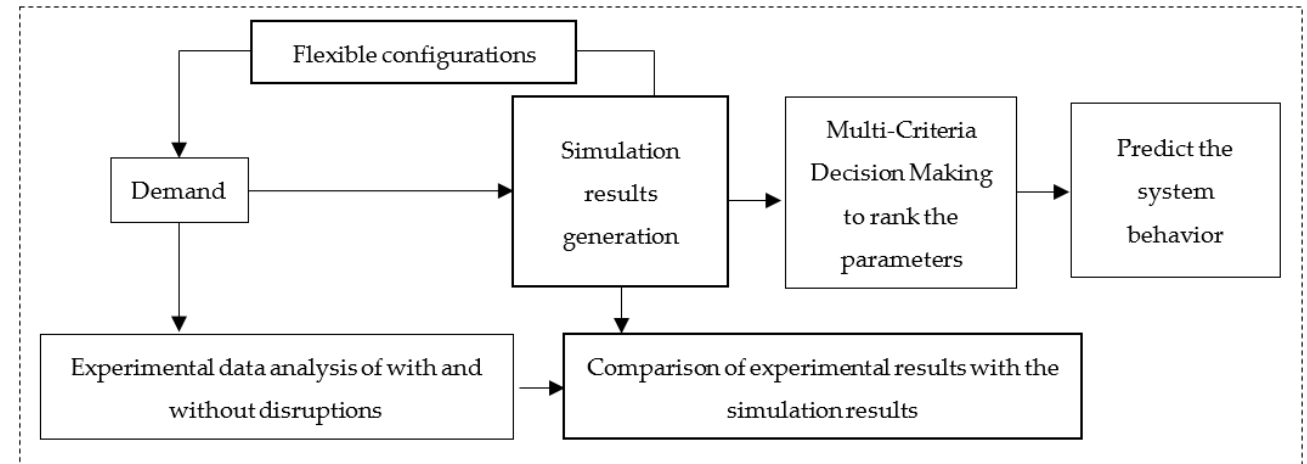
Figure 2. Overview of an integrated MCDM-based simulation approach.